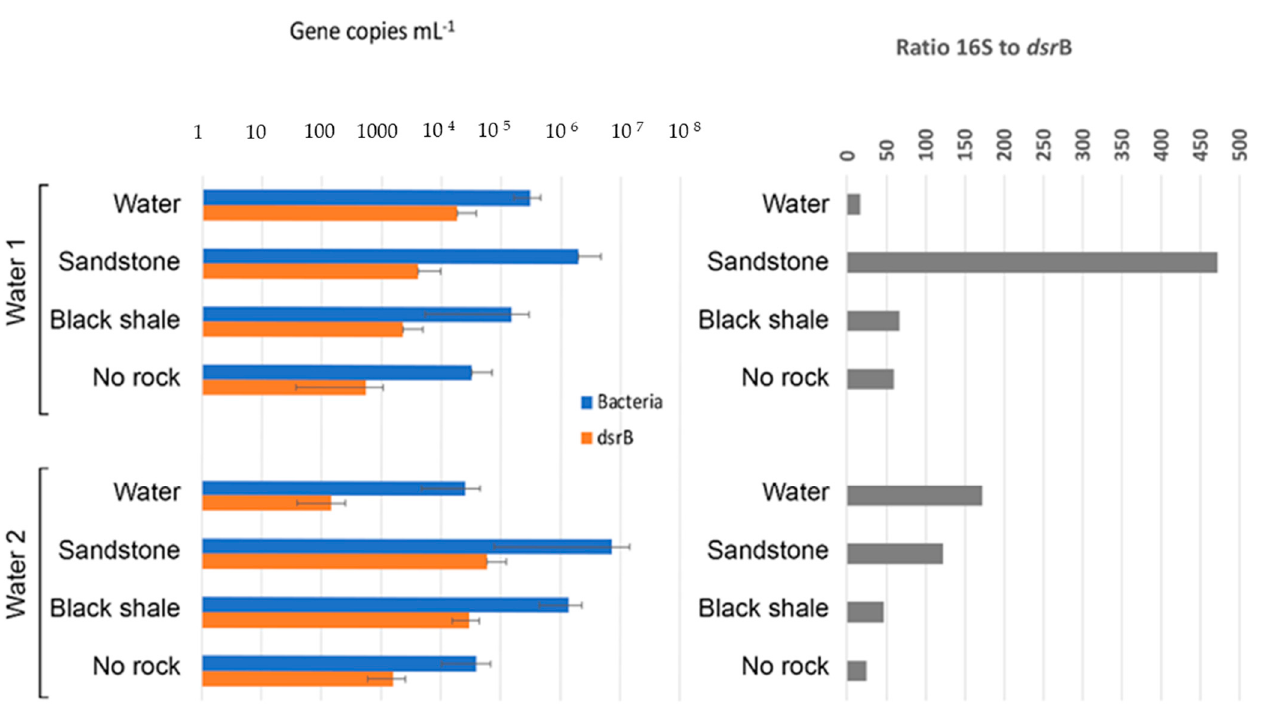
Figure 5. The average number of bacterial 16S rRNA gene and dsr B gene copies of sulphate reducers mL − 1 in the mine waters and microcosm waters (left) and the ratio of 16S rRNA gene copies to dsr B gene copies (right). The measurements are based on one sample from two replicate microcosms and three replicate qPCR reactions per sample at the end of the incubation. The error bars indicate standard deviation (STD).